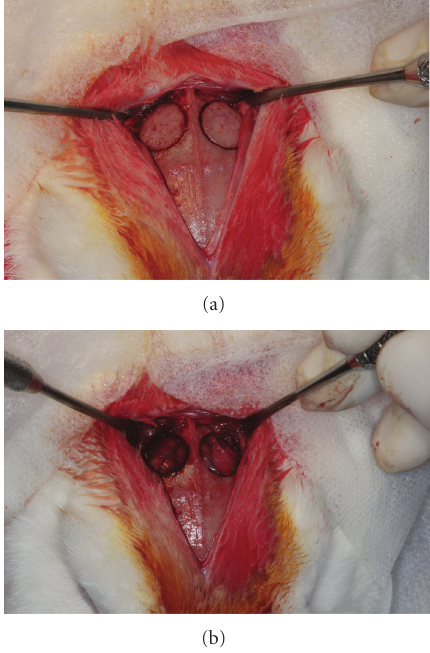
Figure 3: Critical-size defects in the parietal bones made with a trephine bur. (a) Before removal and (b) after